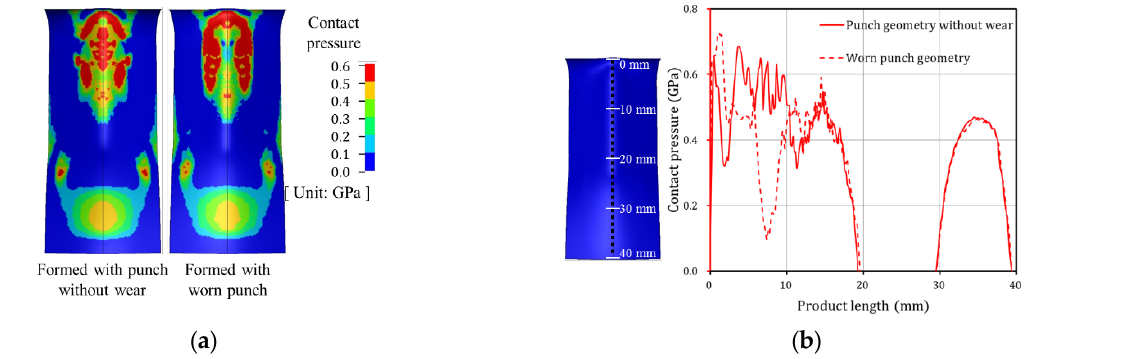
Figure 17. Simulation results based on simplified Archard’s wear model for CrN-coated punches.